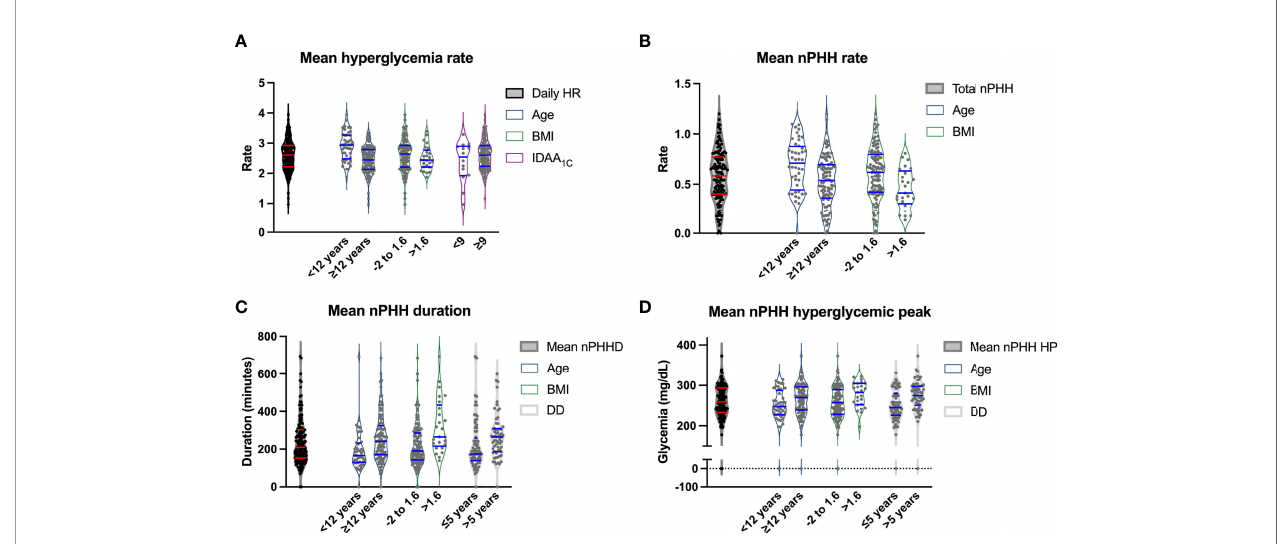
FIGURE 3 | Relations between cohort characteristics, diabetes parameters, and features of PHH. Violin plots representing in the vertical axis mean hyperglycemic rate (A) , PHH rate (B) , PHH duration (C) and PHH hyperglycemic peak (D) according to age <12 versus ≥ 12 years, BMI between -2 and 1.6 versus >1.6, mean IDAA 1C <9 versus ≥ 9 (A) , and diabetes duration ≤ 5 versus >5 years (C , D) . The fi rst plot corresponds to the data range of the vertical variable. The horizontal blue lines correspond to the median and 95% con fi dence intervals. HR, hyperglycemic rate; BMI, body mass index; PHH, post-hypoglycemic hyperglycemia; PHHD, PHH duration; DD, diabetes duration; PHH HP, PHH hyperglycemic